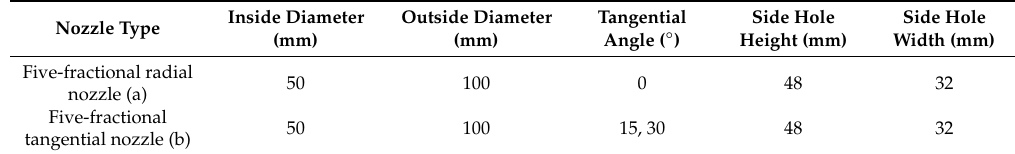
Figure 1. Structural schematic of the mold and submerged entry nozzle. ( a ) Five- fractional SEN with outlets in radial direction ( b ) Five- fractional SEN with outlets in tangential direction. Table 1. Geometric parameters of various SENs.